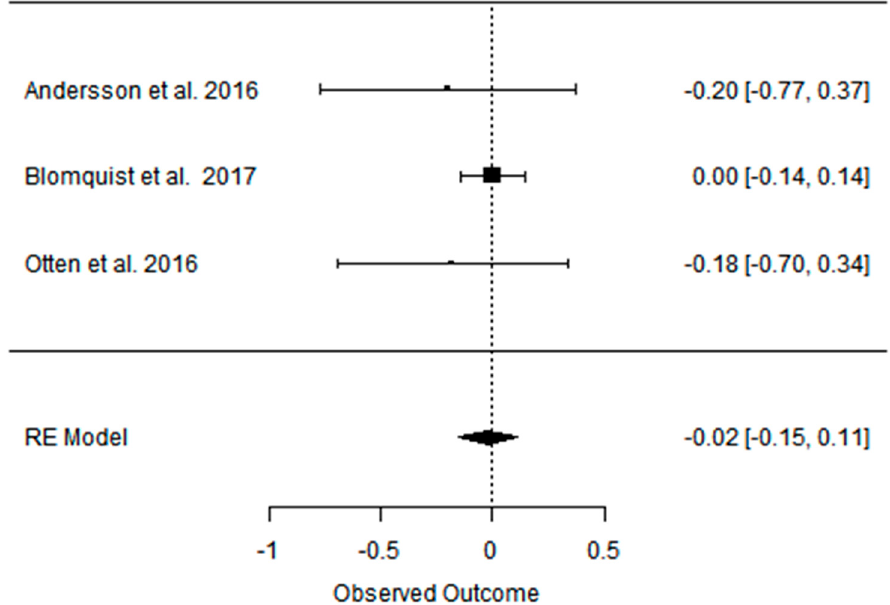
Figure A53. Forest plot of the effect of a PD on HOMA-IR in the long term (weighted mean difference).